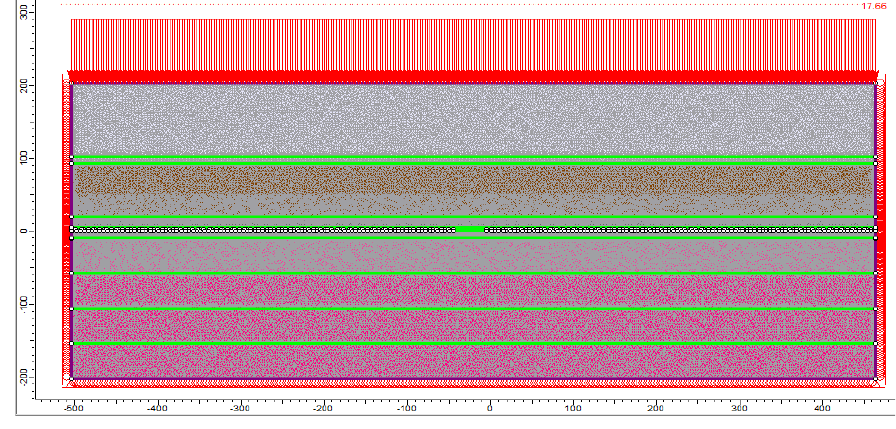
Figure 5. Calculation scheme for D-IE mining field.